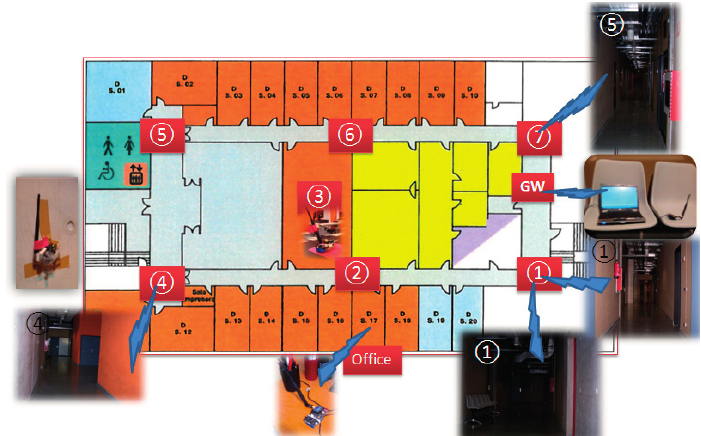
Figure 14. Map of the experimental